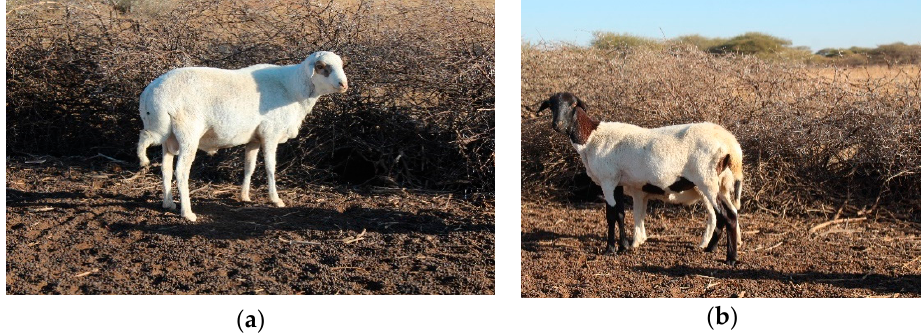
Figure 1. ( a , b ): Pictures of indigenous Tswana sheep. Figure 1. ( a ) Indigenous Tswana ram, ( b ) Indigenous Tswana ewe: Pictures of indigenous Tswana